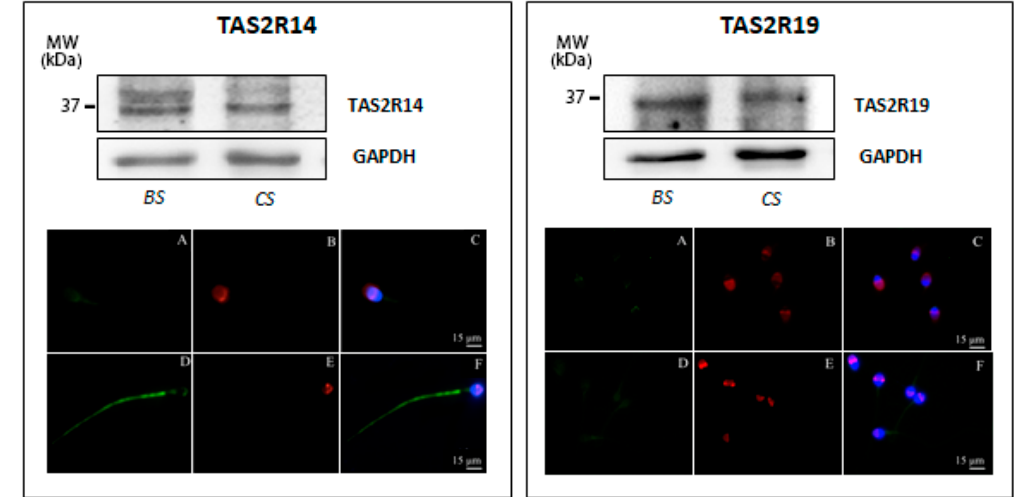
Figure 3. Expression of TAS2R14 (left panel) and TAS2R19 (right panel) in human ejaculated sperm. ( Top ) Western blot of TAS2R14 and TAS2R19 in ejaculated sperm before (BS) and after in vitro capacitation (CS). Equal protein loading of lanes of both sperm preparations was confirmed using an antibody recognizing GAPDH. ( Bottom ) Representative images (from three independent experiments) of immunofluorescence staining of TAS2Rs (green), PSA (red), and DAPI (blue) in ejaculated sperm in basal conditions ( A – C ) and after in vitro capacitation ( D – F ). Scale bar = 15 μ m.